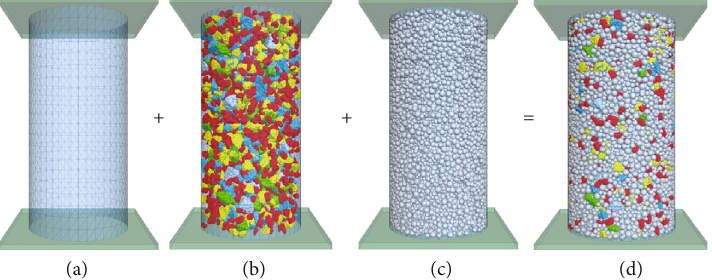
Figure 4: Schematic diagram of gravel soil numerical model construction: (a) empty model; (b) gravel particles; (c) soil particles; (d) complete